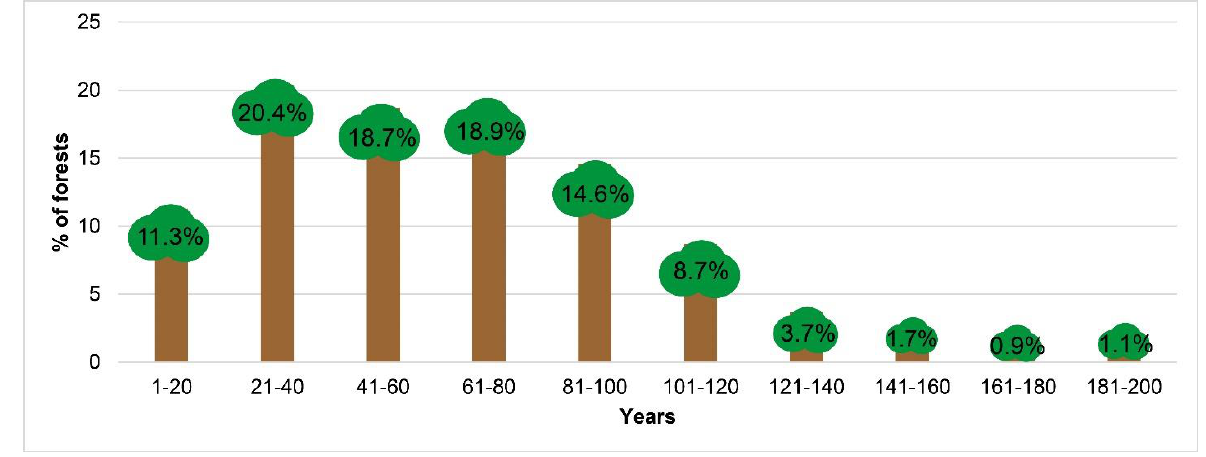
Figure 3. Age class distribution of Romanian forests (data source: [35]).